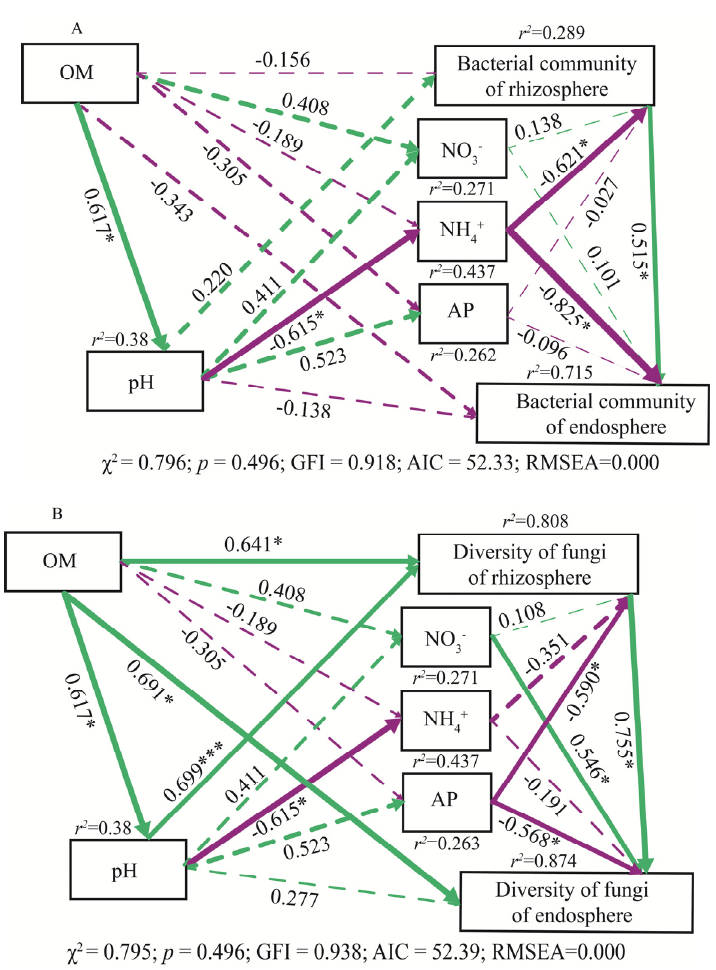
Figure 8. Structural equation model (SEM) shows influential factors of soil properties on the bacterial community ( A ) and fungal diversity ( B ). Green and brown arrows indicate positive and negative relationships, respectively. Significant levels are denoted * p < 0.05, ** p < 0.01, *** p < 0.001. Solid and dotted lines represent significant and insignificant di ff erences, respectively. r 2 values indicate the proportion of variance explained for each variable. The low chi-square ( χ 2 ), nonsignificant probability level ( p > 0.05), high goodness-of-fit index (GFI > 0.90), low Akaike information criteria (AIC), and low root-mean-square errors of approximation (RMSEA < 0.05) listed below the SEMs indicate that our data matches the hypothetical models.